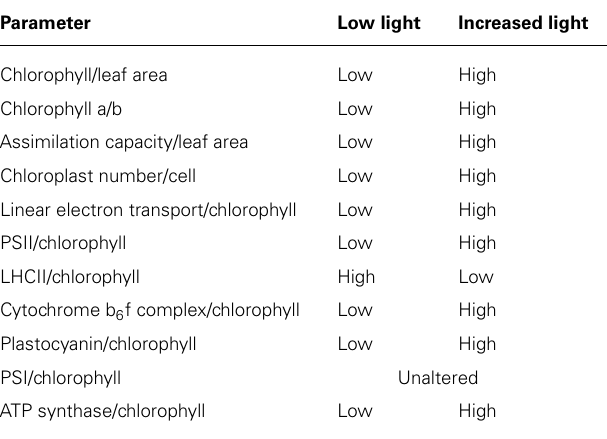
Table 1 | Changes in photosynthetic parameters during the acclimation to increased actinic light